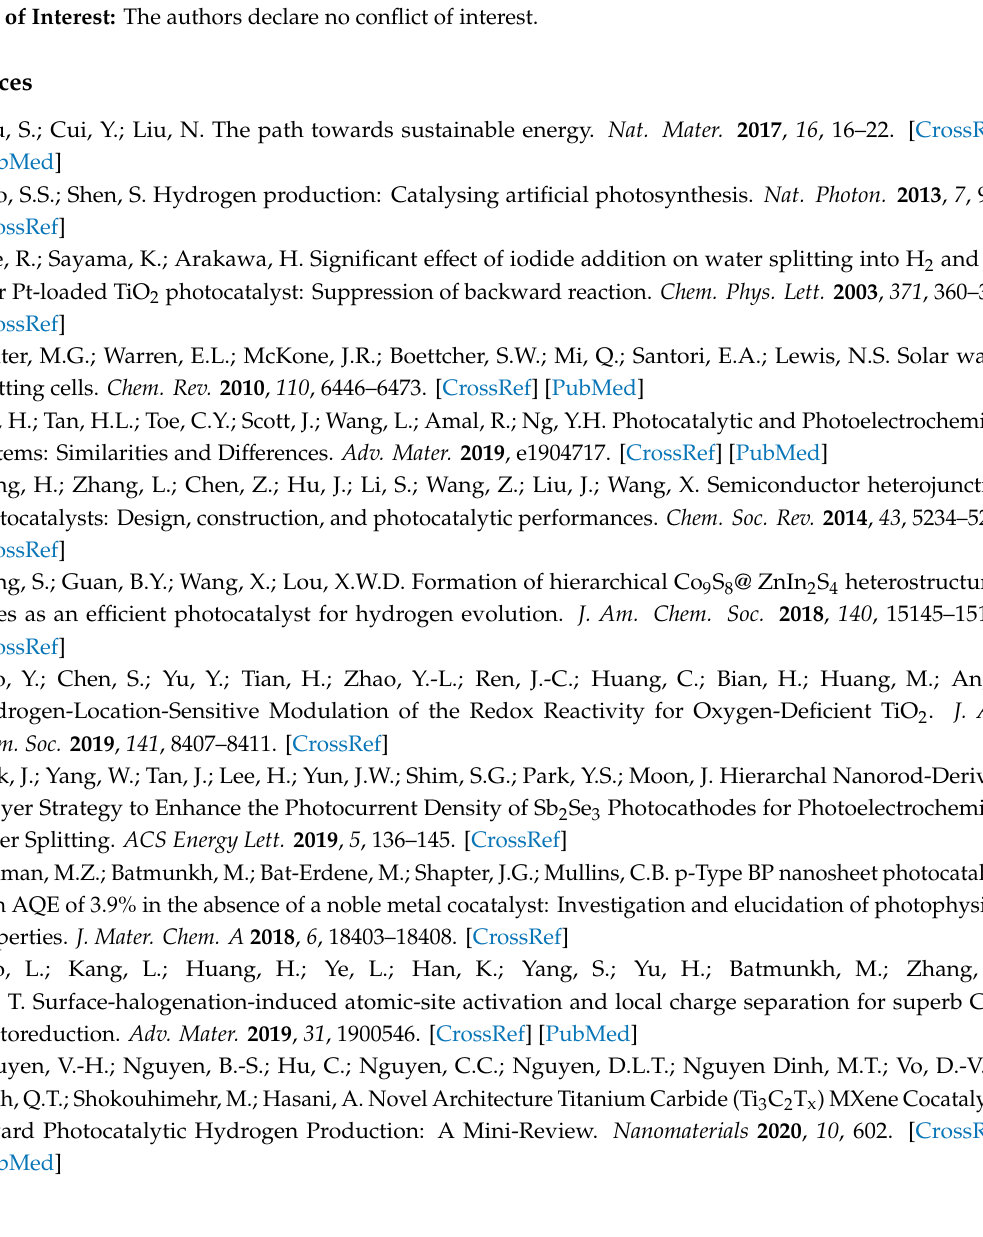
Figure S1: SEM image of the mesoporous TiO 2 / ZnSe NRs photoanode; Figure S2: UV-vis absorption spectra of the TiO 2 photoanode (black) and the TiO 2 / ZnSe NRs photoanode without applying sulfur passivation (red); Figure S3: Transient photocurrent density of the TiO 2 photoanode (black), and the TiO 2 / ZnSe NRs photoanodes with an atomic sulfur passivation for 2 min (red) and 7 min (blue); Figure S4: Zn 2p XPS spectra of TiO 2 / ZnSe NRs photoanodes with atomic sulfur passivation for 0, 5, and 15 min; Figure S5: (a) XRD patterns, (b) UV-vis absorption spectra, and (c) PL spectra of ZnSe NRs (black) and ZnSe / ZnS core / shell NRs (red). (d) Transient photocurrent density of TiO 2 photoanodes modified with ZnSe NRs (black) and ZnSe / ZnS core / shell NRs (red); Figure S6: Transient photocurrent density of the TiO 2 / ZnSe NR-based photoanodes coated with ZnS passivation layers with di ff erent thickness and deposition sequence, (a) from Zn 2 + to S 2 − and (b) from S2 − to Zn 2 + using successive ionic layer adsorption and reaction (SILAR)